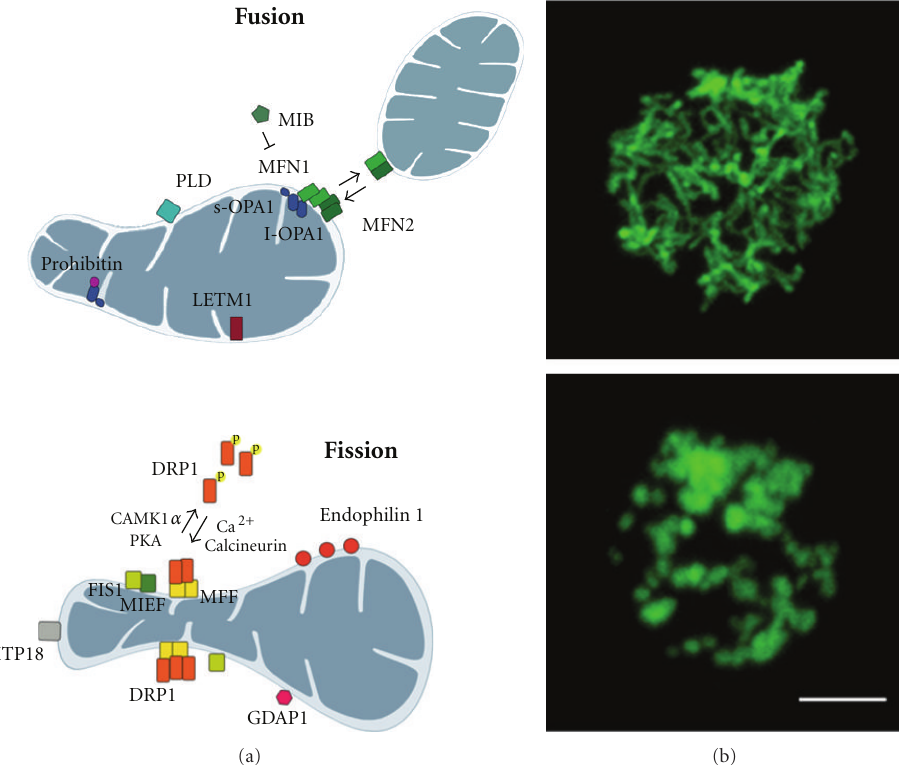
Figure 1: The dynamic nature of mitochondrial shape. (a) Main proteins involved in mitochondrial shape changes are depicted. In fused unopposed condition, DRP1 is phosphorylated and sequestered in the cytoplasm. Once dephosphorylated, it is recruited to the OMM where it oligomerizes and interacts with FIS1, MFF, or MIEF inducing constriction of membranes and, eventually, fission of mitochondria. MFNs homo- and heterooligomerization on the OMM and oligomerization between long and short isoform of Opa1 on the IMM control fusion of mitochondrial membranes. Additional proteins a ff ecting mitochondrial shape are also shown. (b) Mitochondrial morphology in Jurkat cells overexpressing yellow fluorescent protein targeted to mitochondria. The upper panel shows a network of elongated and interconnected mitochondria. In the lower panel, mitochondria appear fragmented (Scale bar: 5 μ